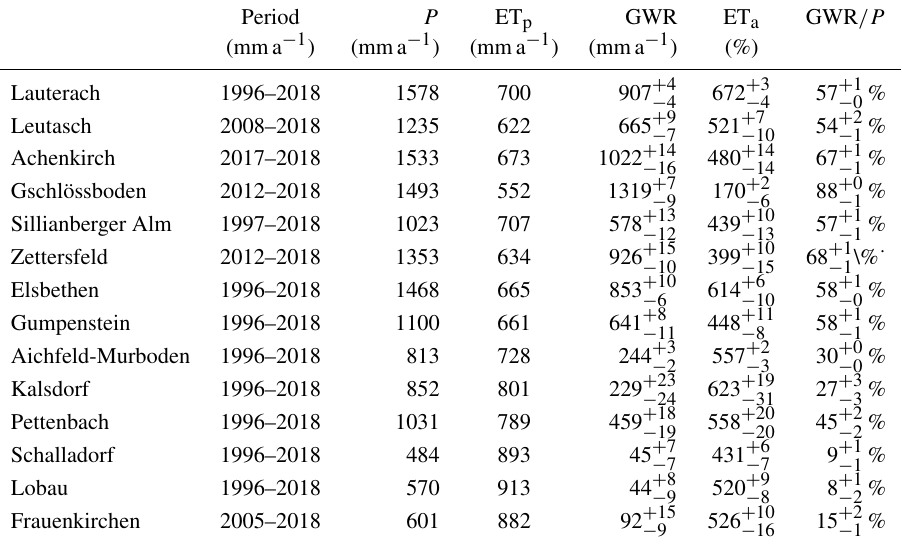
Table 2. Local long-term average water balances at 14 sites, showing precipitation ( P ), potential evapotranspiration (ET p ), and the simulated potential groundwater recharge (GWR) and actual evapotranspiration (ET a ) with the 95% credible interval from propagated parameter